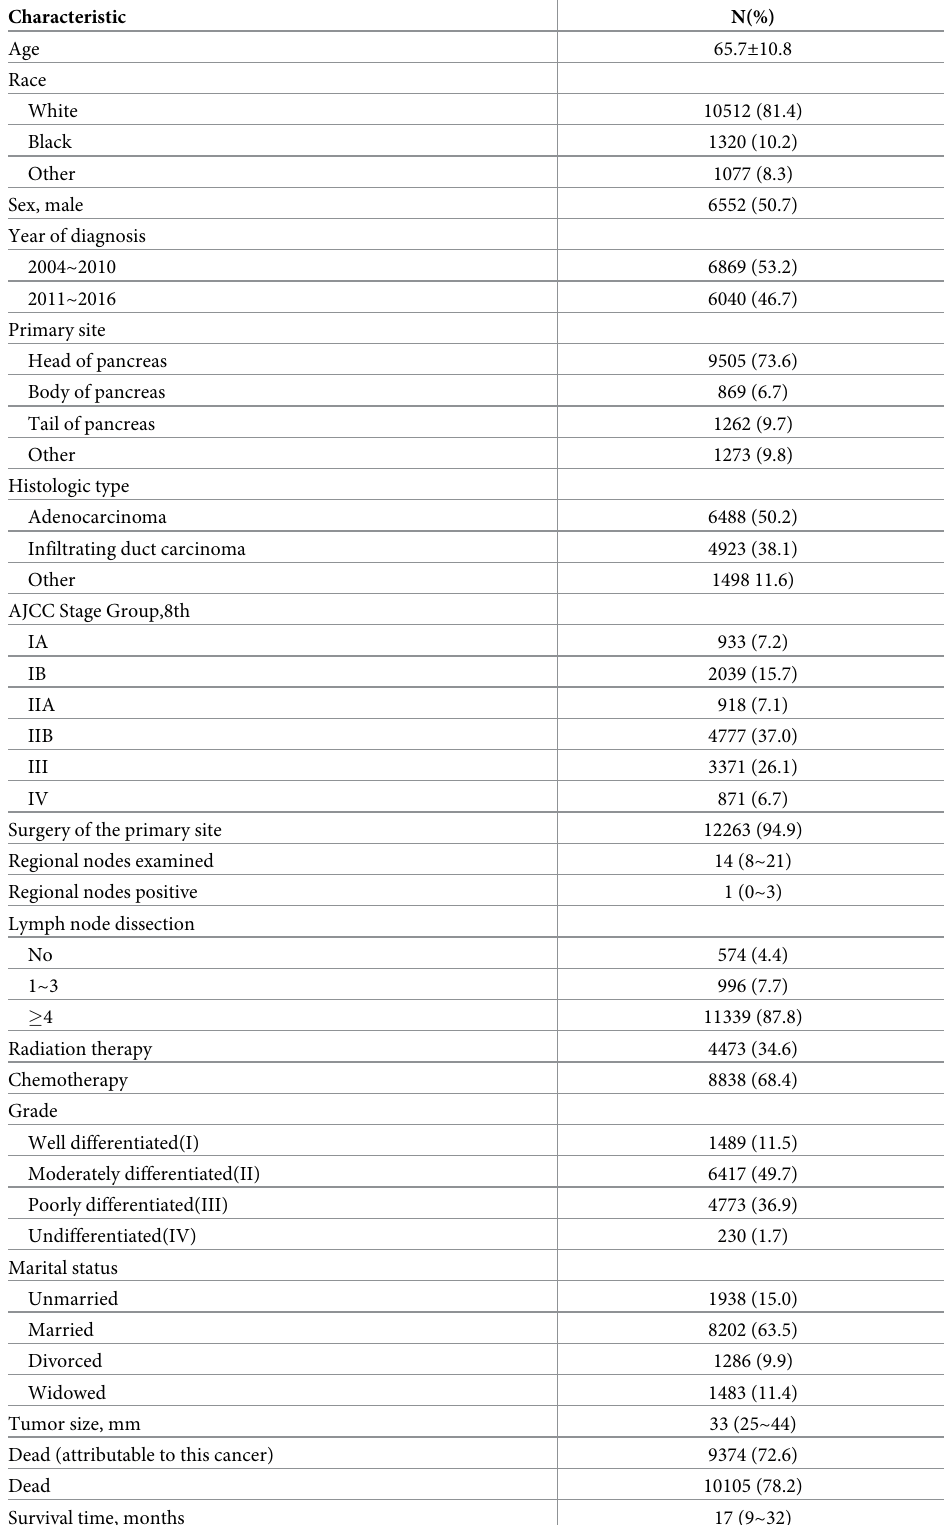
Table 1. Patient demographics (N =